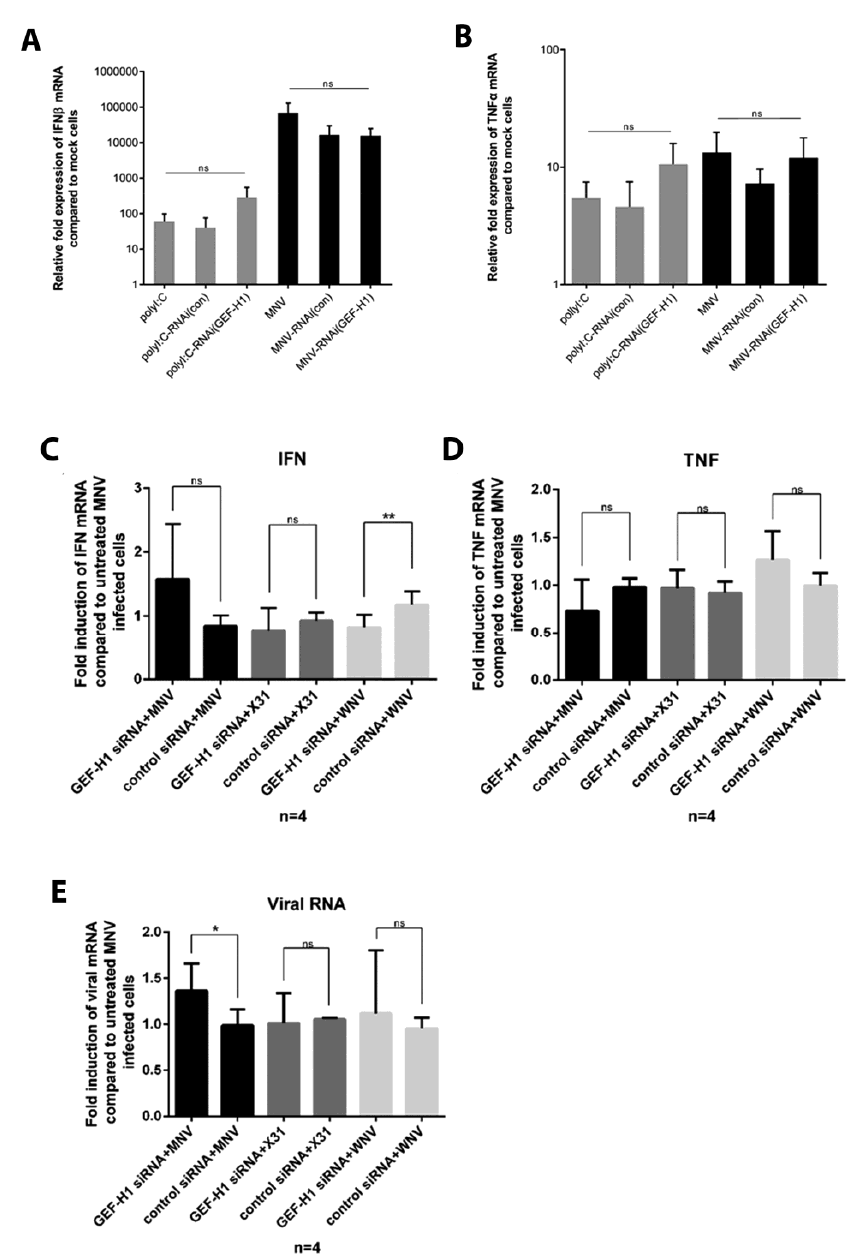
Figure 6. Knockdown of GEF-H1 in murine macrophage cells does not lead to significant changes in the mRNA expression of IFN β and TNF α upon MNV infection. RAW264.7 cells were treated twice with GEF-H1 siRNA (siRNA3) or the control siRNA (siRNA-ve) before cells were either infected with MNV (MOI 5), treated with poly(I:C), or left untreated for 12 h. Cells were lysed, and the RNA was extracted. Relative fold expression of IFN β (panel A) and TNF α mRNA (panel B) compared to mock cells was analysed via RT-qPCR ( n = 3, average +/ − SEM, not significant [ns]: p > 0.05; one-way ANOVA). In panels C and D, RAW264.7 cells were treated twice with GEF-H1 siRNA, the control siRNA, or left untreated before cells were either infected with MNV (MOI 5), X31 (MOI 5), or West Nile Virus (WNV) (MOI 1). Cells were lysed, and the RNA was extracted. Relative fold expression of IFN β ( A , C ), TNF α ( B , D ), and viral mRNA ( E ) compared to infected but untreated cells was analysed via RT-qPCR ( n = 4, average ± SEM, not significant [ns]: p > 0.05, * p < 0.05; one-way ANOVA).